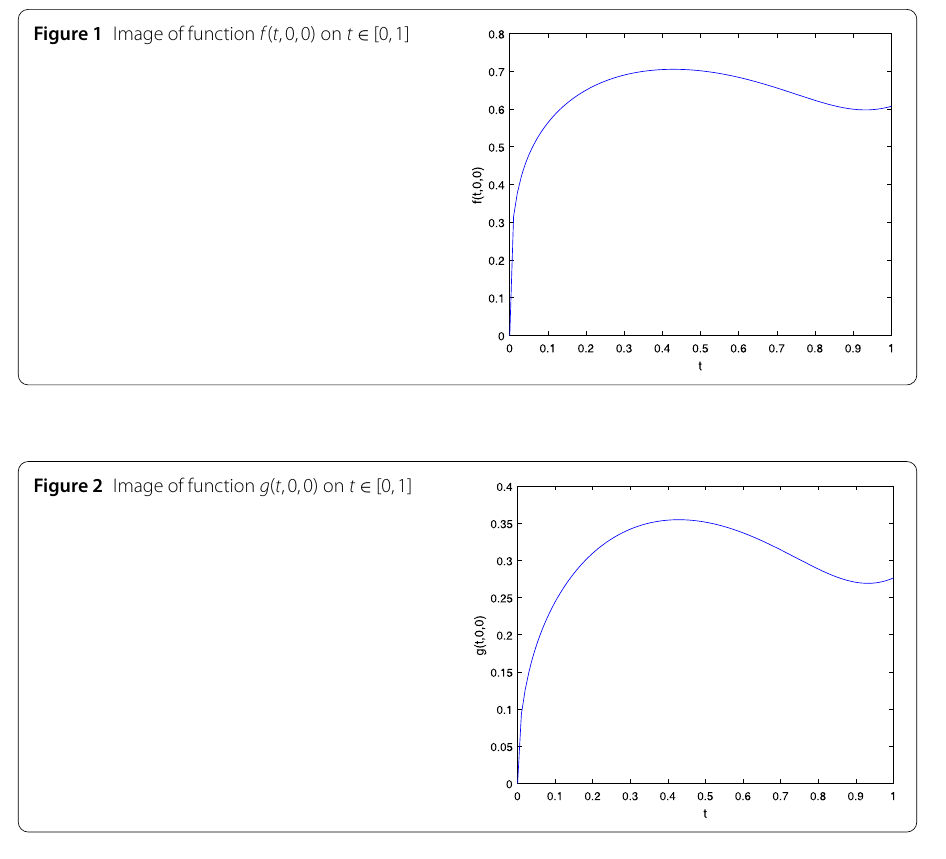
Figure 1 Image of function f ( t ,0,0) on t ∈ [0,1]